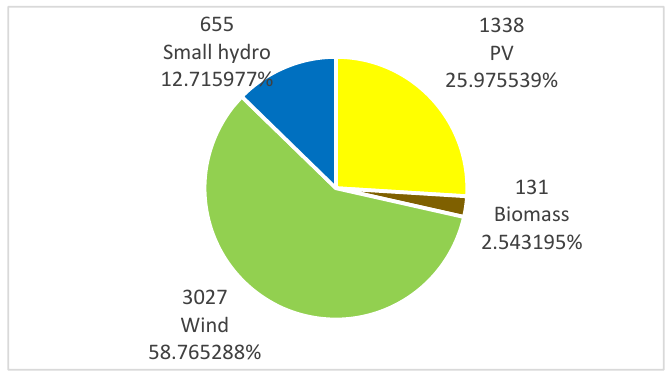
Figure 2. Pi [MW] of wind power plant (WPP) in Romania during 2010–2017.